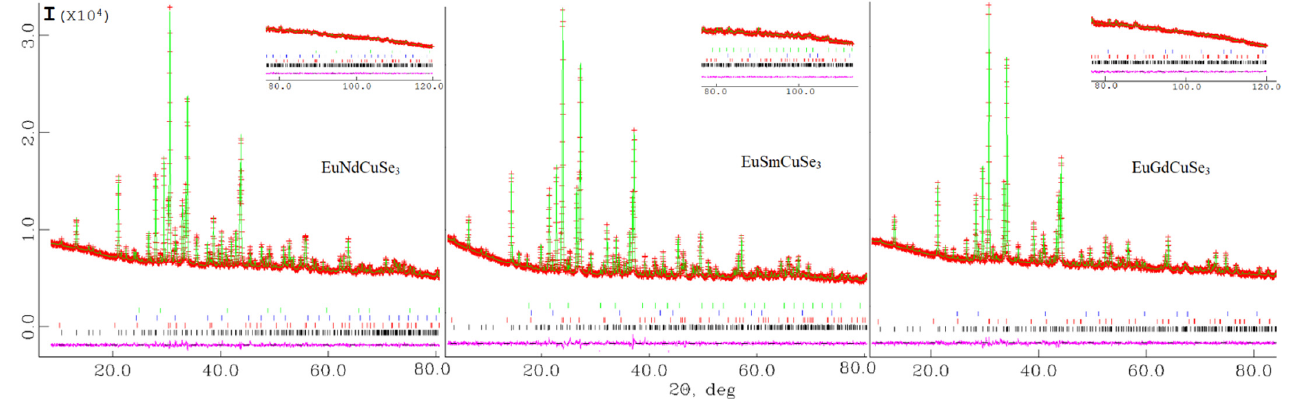
Figure 2. Crystal structure of EuErCuSe 3 .